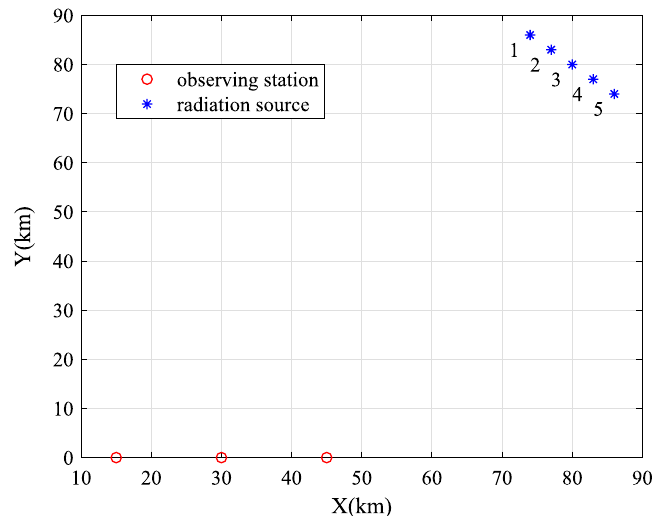
Fig. 4 Coordinates of observation stations and radiation sources